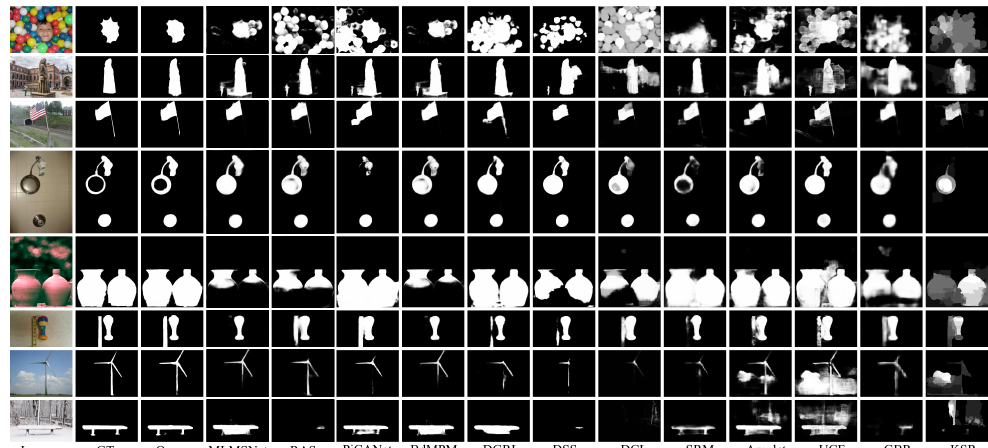
Figure 8. Qualitative comparison of saliency maps. We compare our model with MLMSNet [32], RAS [33], PiCANet [10], BdMPM [54], DGRL [9], DSS [7], DCL [12], SRM [61], Amulet [62], UCF [8], GBR [31], and KSR